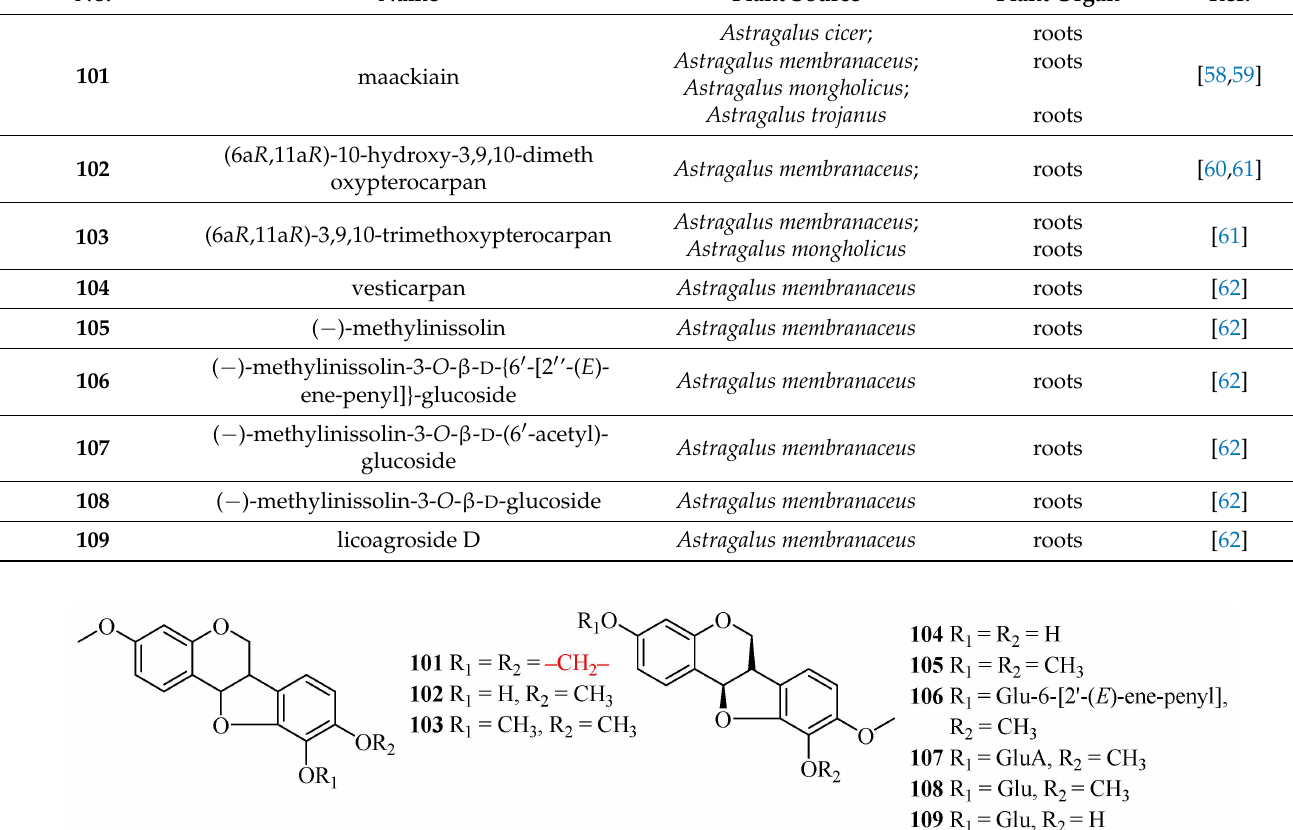
Table 3. The numbers, plant sources, and corresponding organs of isoflavan-4-ols.